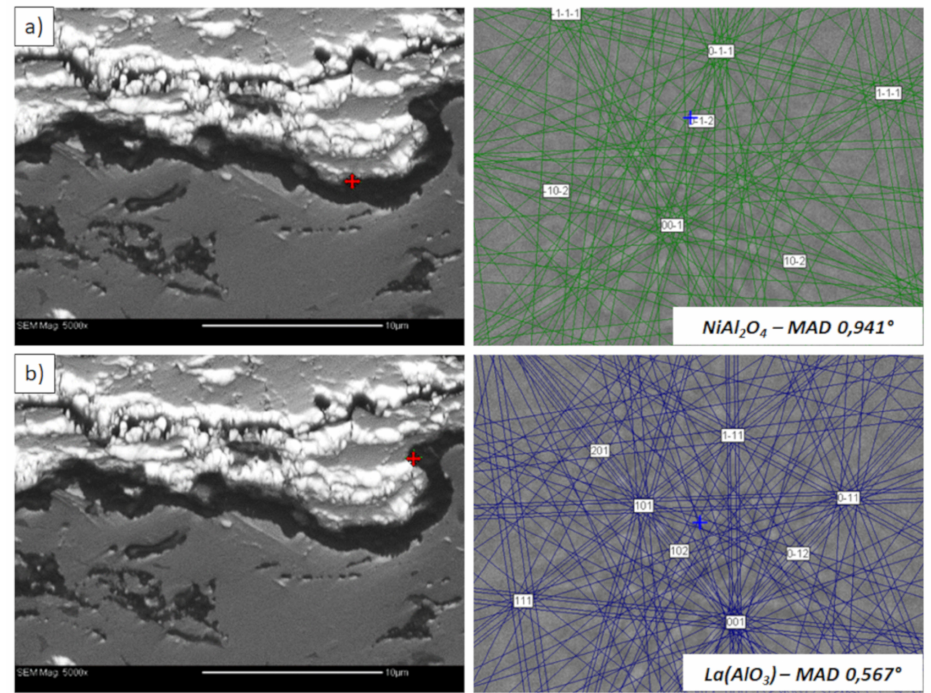
Figure 23. Analysis of phase composition in micro-areas of the TGO zone after 500 h of oxidation at a temperature of 1100 ◦ C by EBSD—La 2 Zr 2 O 7 / TGO interface: ( a ) place of NiAl 2 O 4 detection, ( b ) place of La(AlO 3 ) detection.